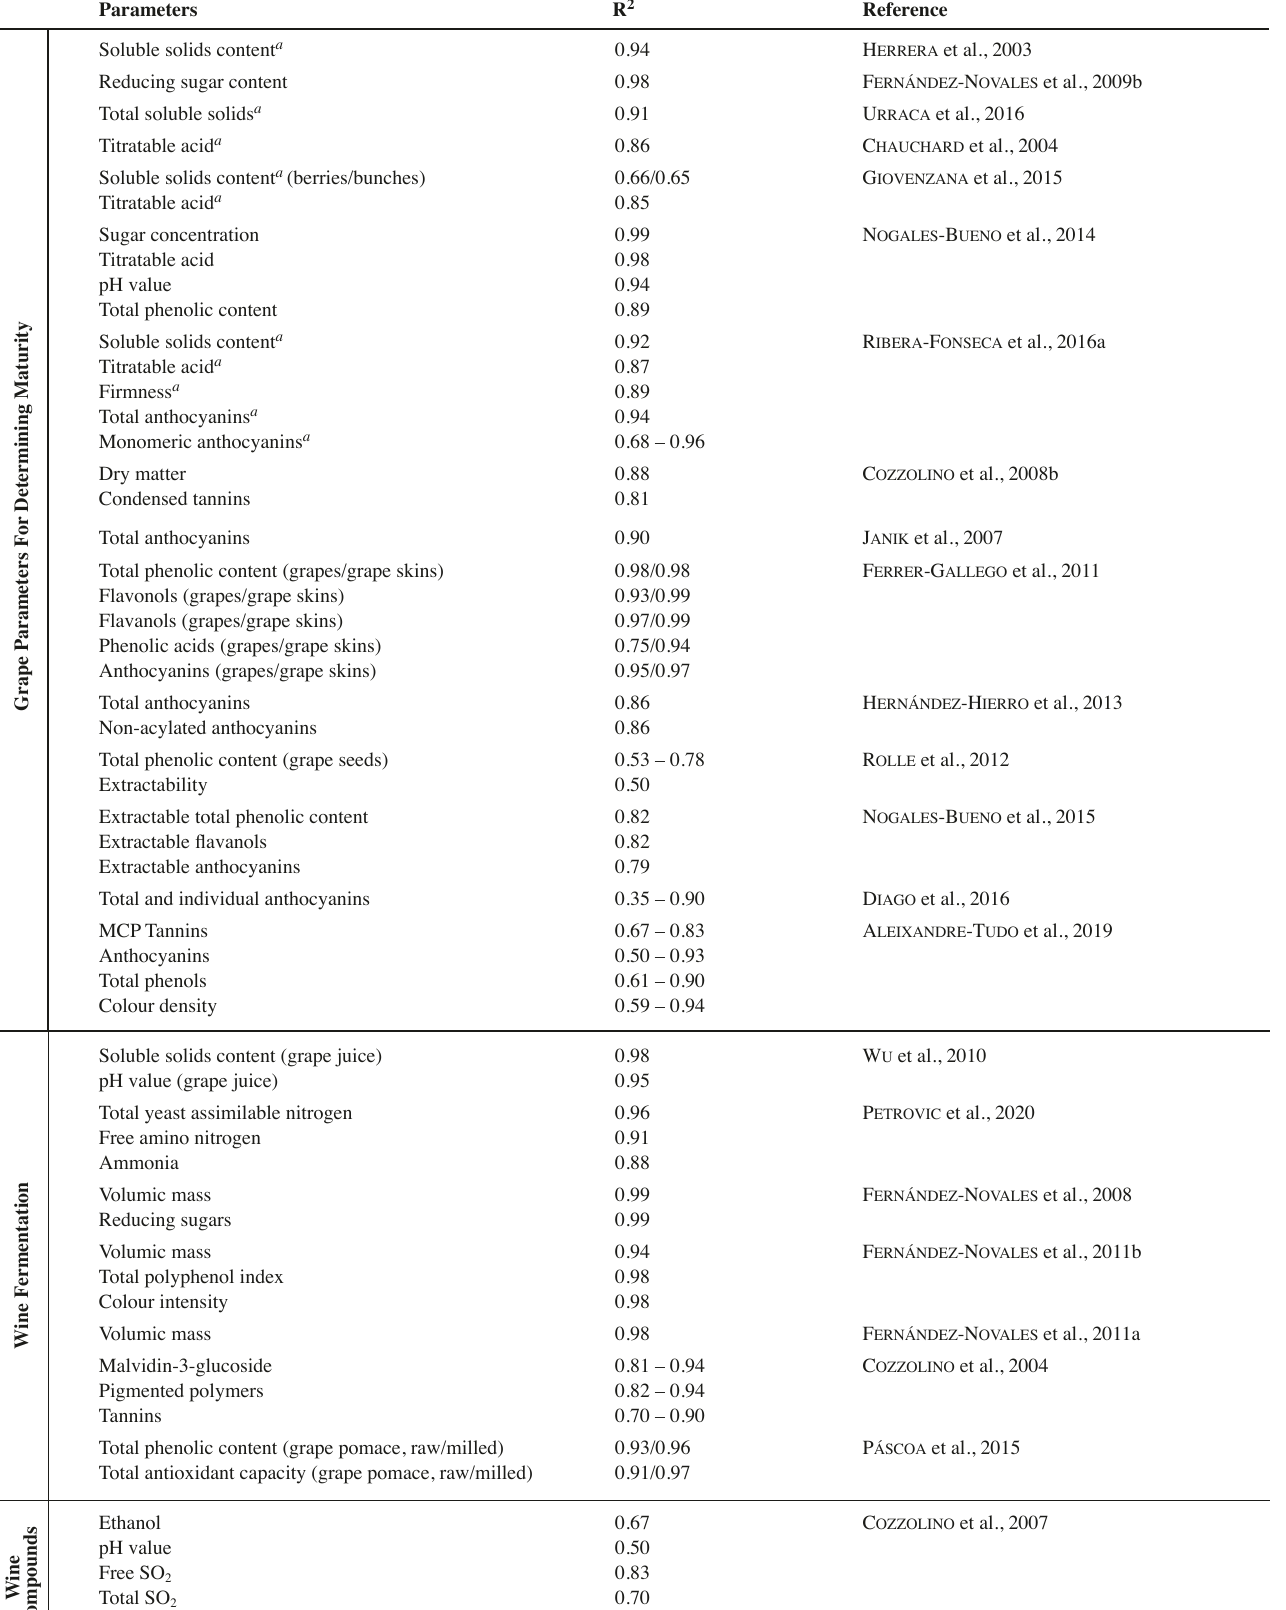
Tab. 2: Applications of NIR spectroscopy in grape and wine